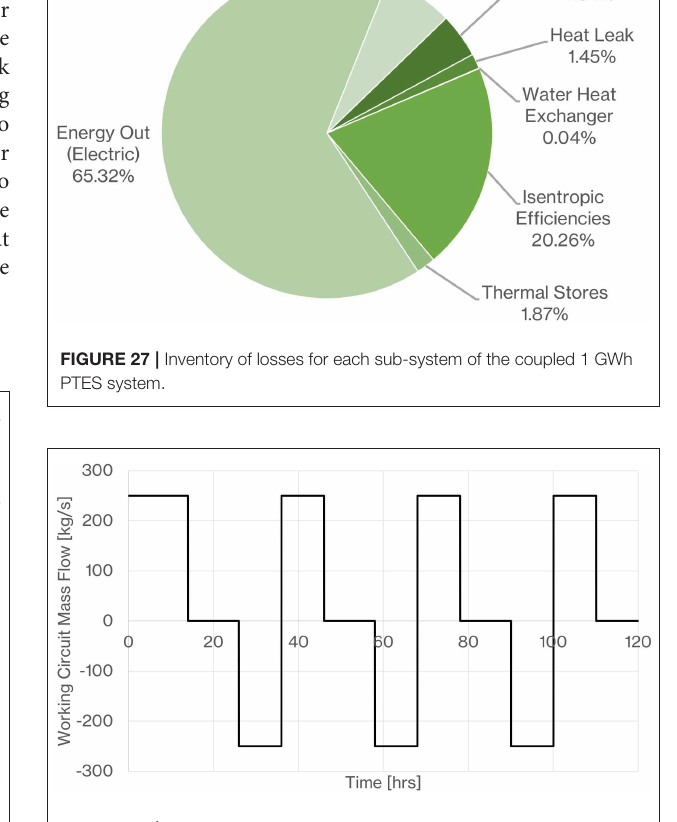
FIGURE 28 | Example repeated operating cycle with dwell time in charged state. On the mass flow axis, + ve refers to charging, -ve refers to